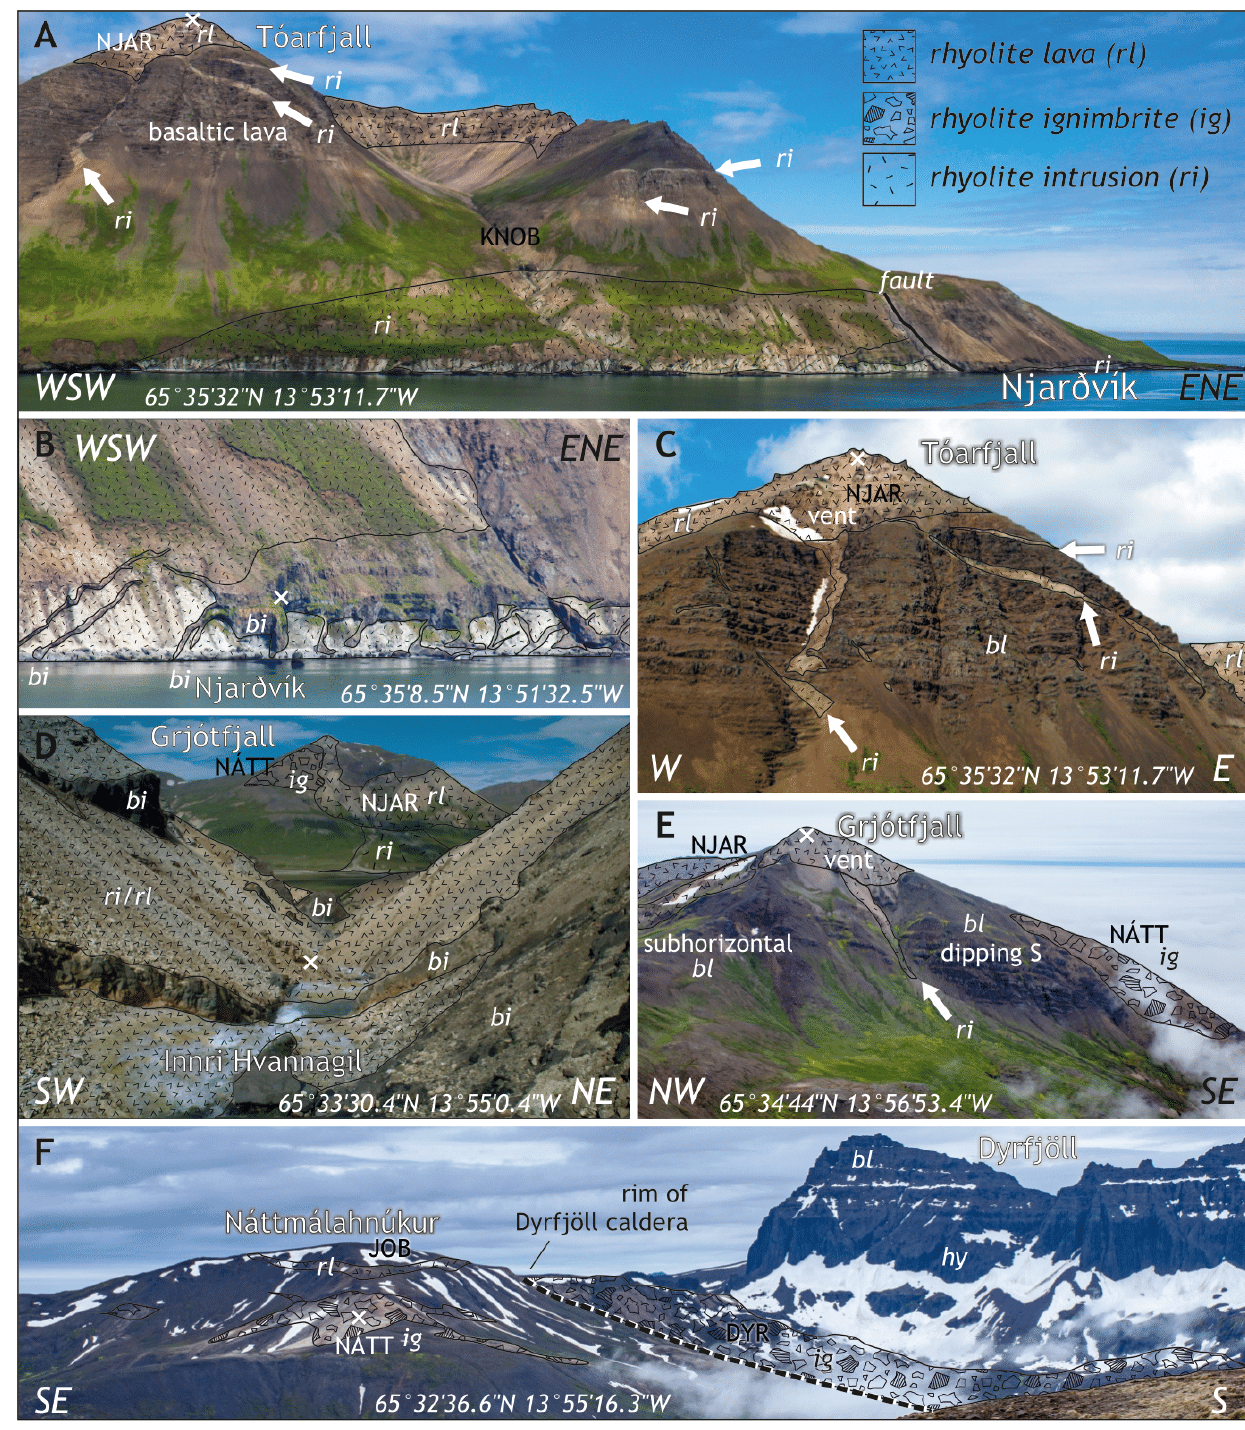
Figure 5: Annotated field photographs illustrating the geology of Njarðvík. For locations see Figure 4. Abbrevi- ations: b = basalt, r = rhyolite, hy = hyaloclastite, l = lava, i = intrusion, ig = ignimbrite. × marks the location of the coordinates mentioned in each photograph. For names of stratigraphic formations, see text and Figure 15. [A] On the northern shore of Njarðvík, white coloured intrusive rhyolites are intruded by black basaltic cone sheets and overlain by grey-brown basaltic lava flows. The mountain peaks around the bay (e.g. Tóarfjall) are formed by rhyolitic lava. [B] The Njarðvík sill [Burchardt 2008] is formed by basaltic cone sheets intruding the white coloured intrusive rhyolite at the northern shore. [C] The peak of Tóarfjall is formed by rhyolitic lava fed by rhyolitic dykes cutting through basaltic lava flows. [D] The sub-volcanic rhyolite exposed in Innri Hvannagil is cut by basaltic dykes and cone sheets. [E] The peak of Grjótfjal is formed by an eruptive vent with rhyolitic pyroclastic rock. The underlying basaltic lavas dip towards the Njarðvík bay as a result of downsagging (see Section 4.5.1 ). [F] View towards Dyrfjöll and Náttmálahnjúkur with the two ignimbrites